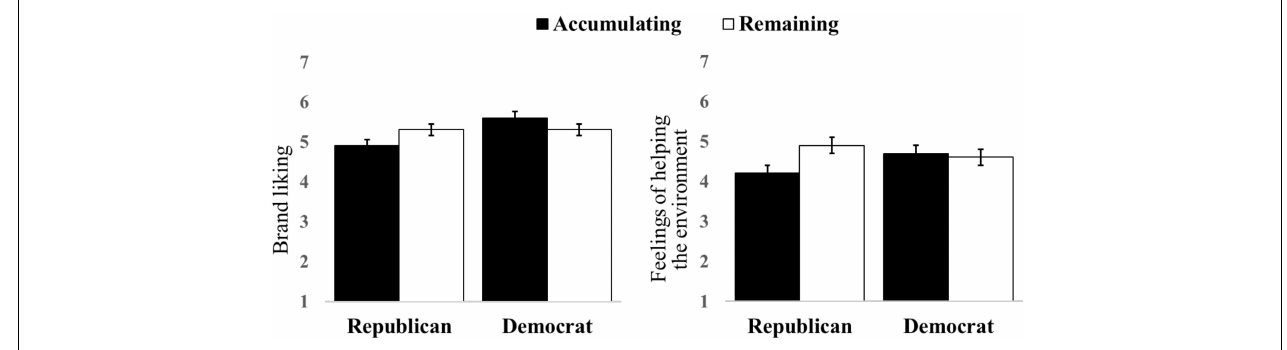
FIGURE 3 | Study 2 Results: Collective progress framing by political affiliation for brand liking (left) and feelings of helping the environment (right)